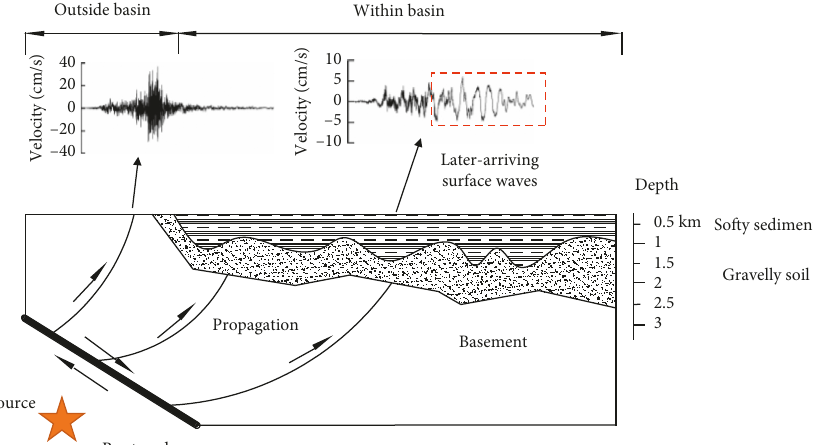
Figure 2: The schematic plot illustrates the mechanism for long-period ground motions.